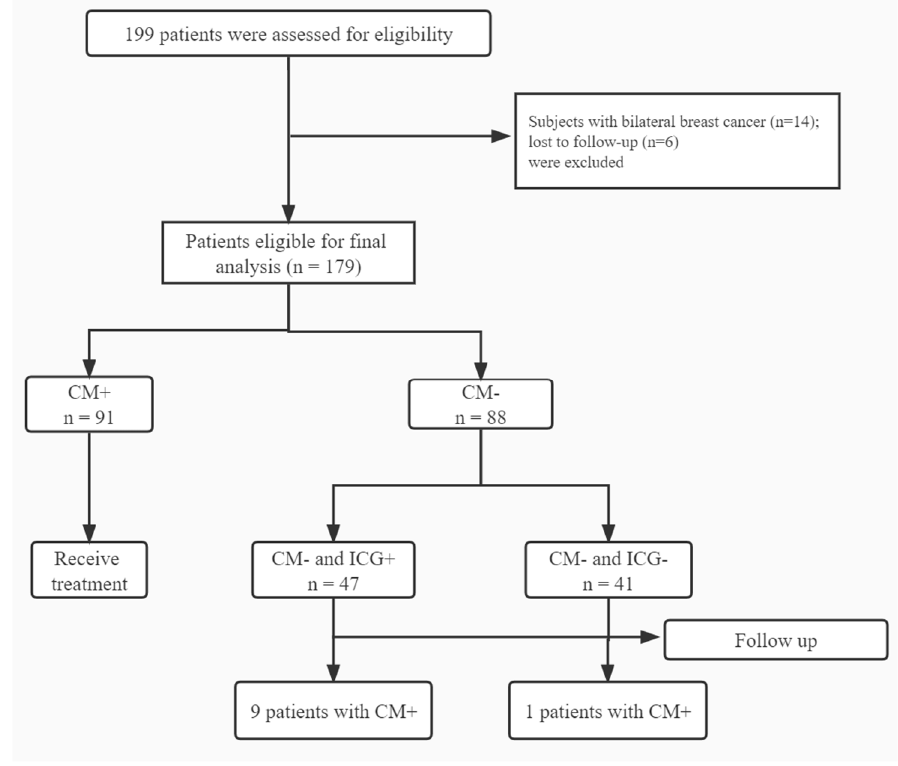
Figure 1. Flowchart of the process of patients’ enrollment (ICG, indocyanine green; CM: circumference measurement). Table 1. Univariable logistic regression of participant